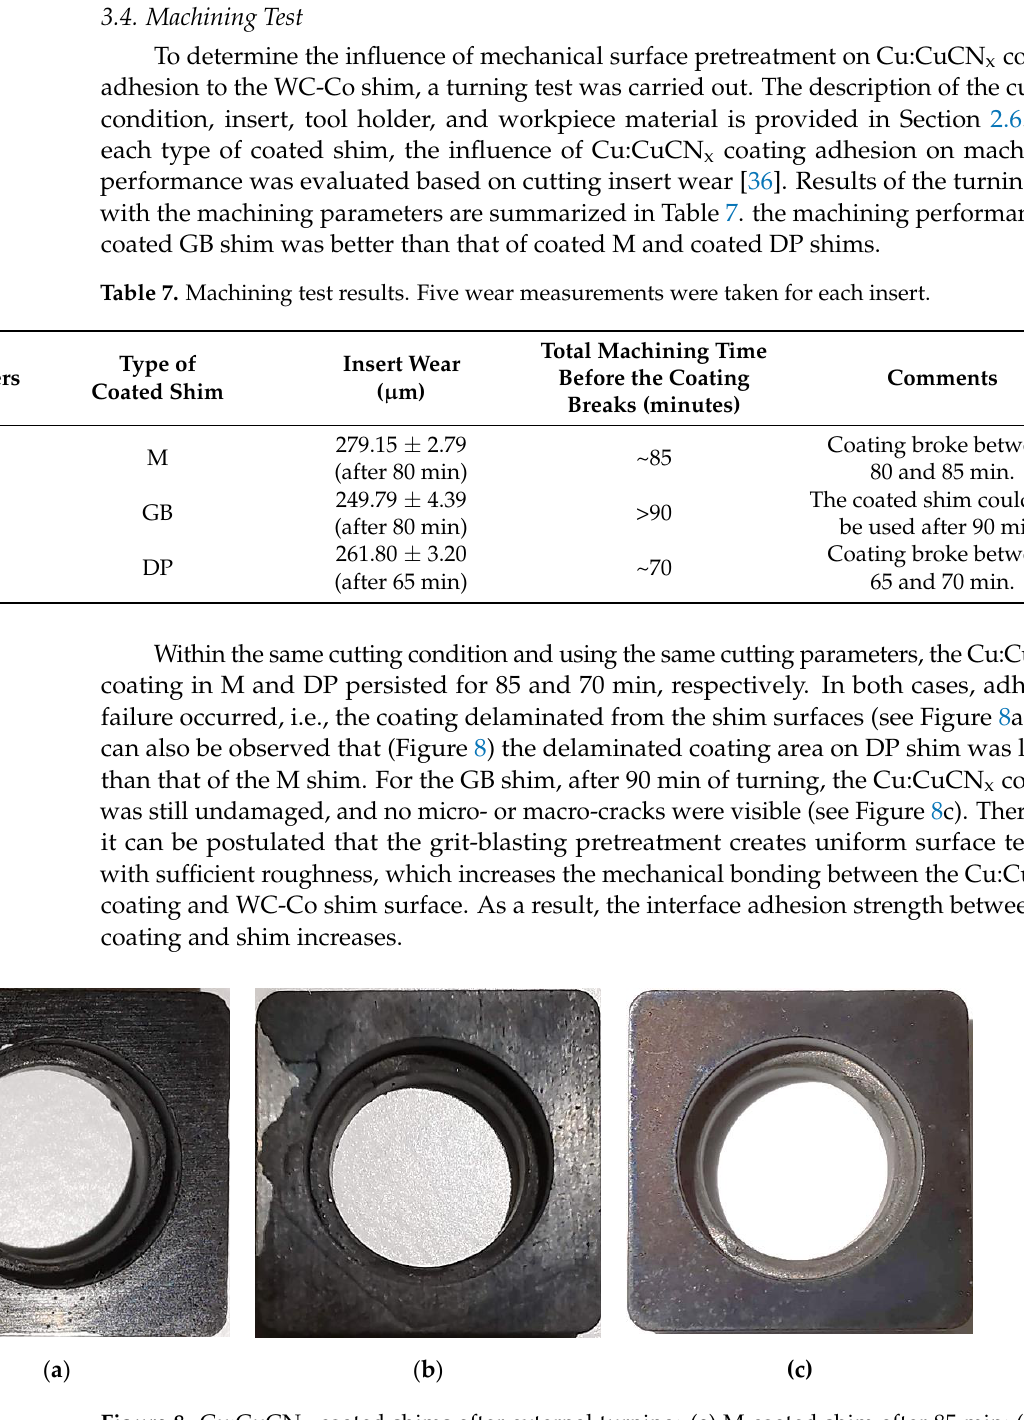
Figure 8. Cu:CuCN x -coated shims after external turning: ( a ) M coated shim after 85 min; ( b ) DP coated shim after 70 min; and ( c ) GB coated shim after 90 min.